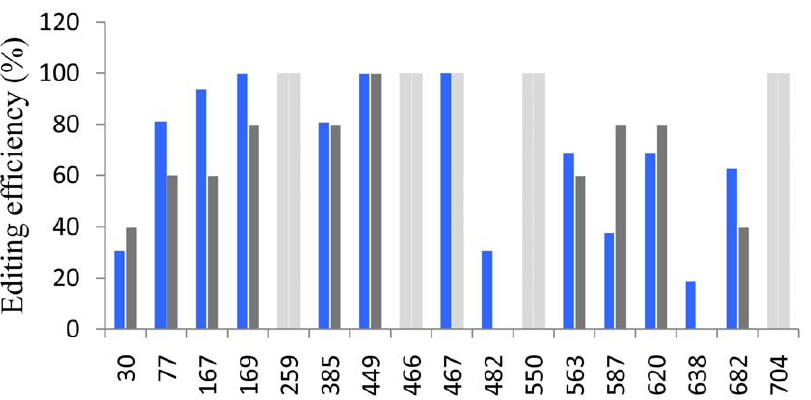
Figure 3. Editing of cox2 transcripts carrying pre-edited sites. Residues C259, C466, C467, C550 and C704 were changed into T (pre-edited) on the cox2 transgene. The editing efficiency of the remaining sites was determined by sequencing at least 16 independent RT-PCR clones obtained from spliced products. Gray bars represent the values obtained from wild type transcripts. Blue bars indicate the values from mutated mRNAs. Pre- edited sites are depicted by light gray bars. The results presented are representative from at least two separate experiments. Editing efficiency variations in replicates was lower than 10%.